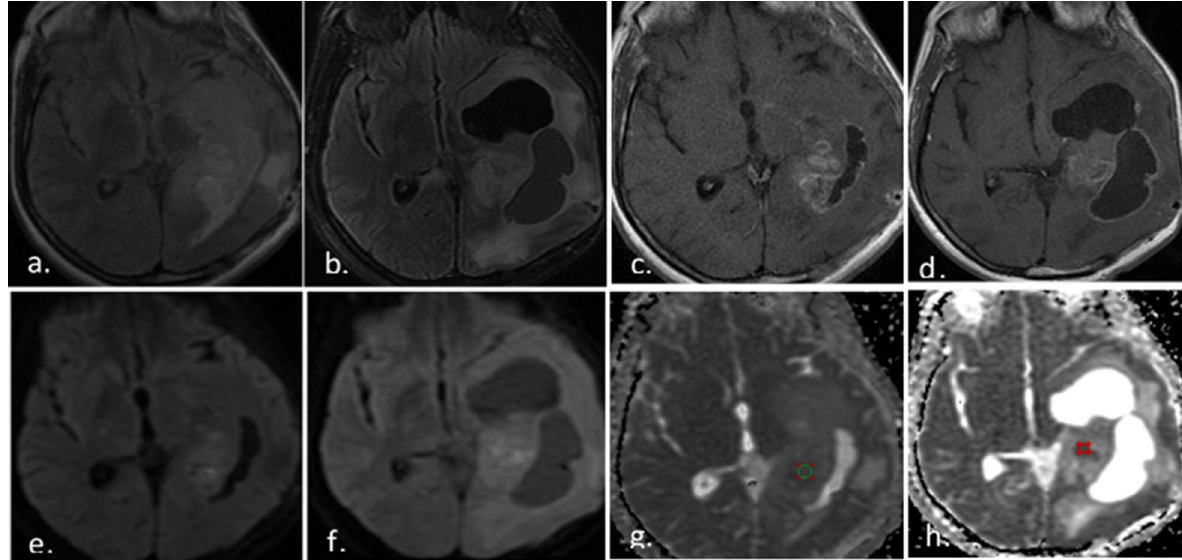
Fig. 5 A 47-year-old clinically-deteriorated male patient with left temporo-parietal grade IV glioblastoma multiforme finished chemoradiotherapy 9 months ago. a and b Axial FLAIR images of the first and second studies, respectively show an increase of the FLAIR component by less than 25%. Increase mass effect on the second follow-up study. c and d Axial post-contrast T1 WIs of the first and second studies, respectively show an increase in the enhancing component by less than 25% in the follow-up study. e and f Axial DWI and (g and h) Axial ADC maps show a decrease of ADCmean in the heterogeneously enhancing component (0.99 10 − 3 mm 2 /s) and (0.75 10 − 3 mm 2 /s) in the first and second studies, respectively. × × BT-RADS category 3c was given that favors tumor progression. Decrease ADCmean ascertains the possibility of tumor recurrence.